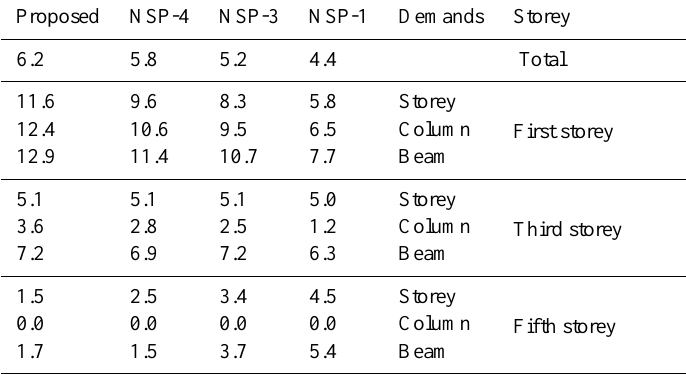
Table 7. Summary of ductility demands for 6-storey building.